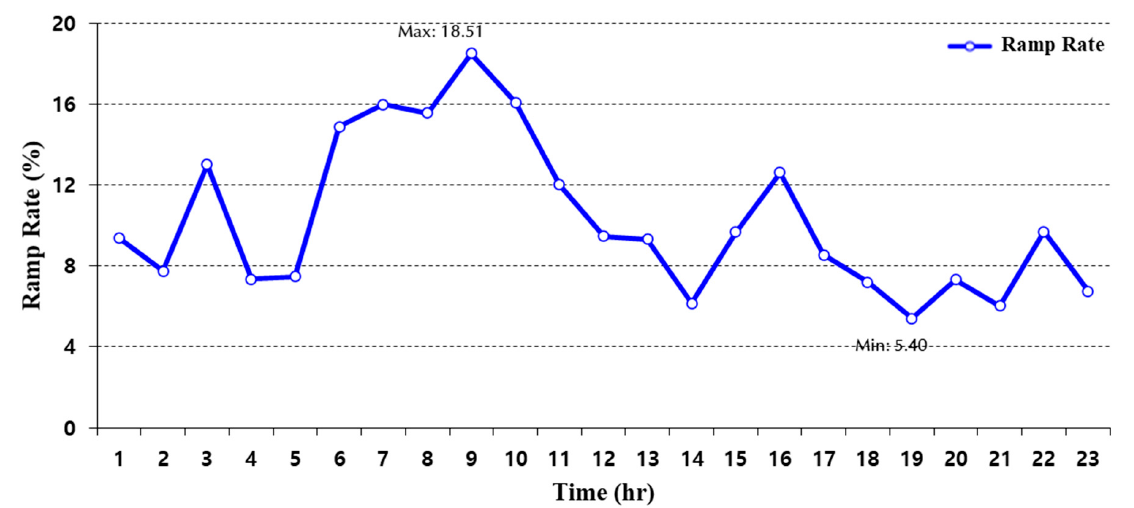
Figure 3. Hourly ramp rates of 2018.